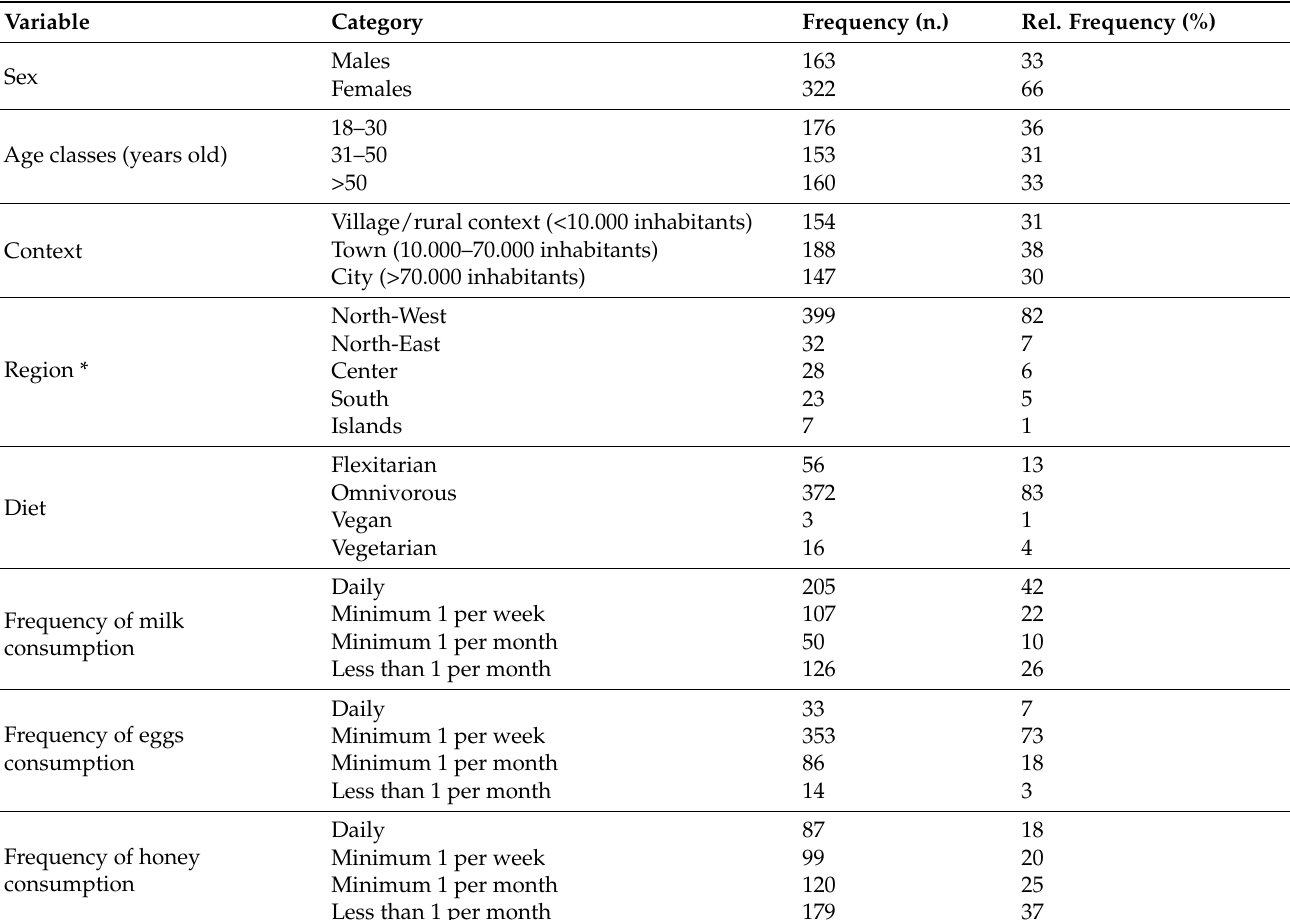
Table 2. Characteristics of the